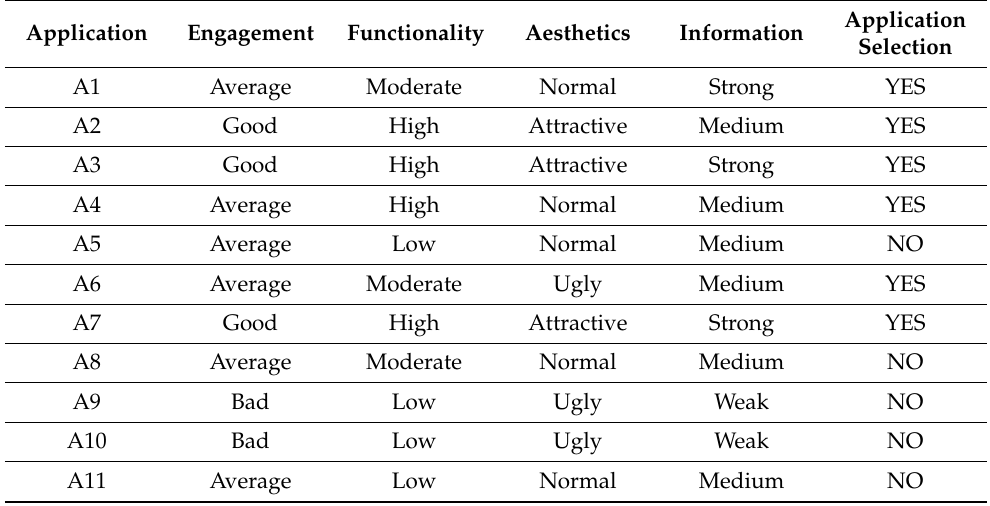
Table 5. Decision-making factors to select the application (data set).